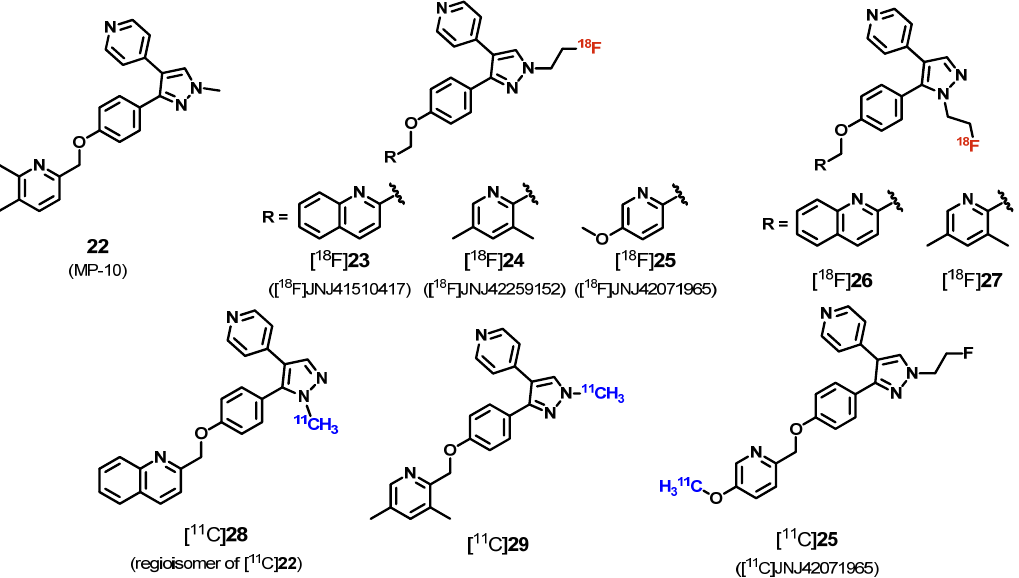
Figure 5. Figure 5. Molecular structures of PDE10A inhibitor 22 and 11 C- or 18 F-labeled derivatives